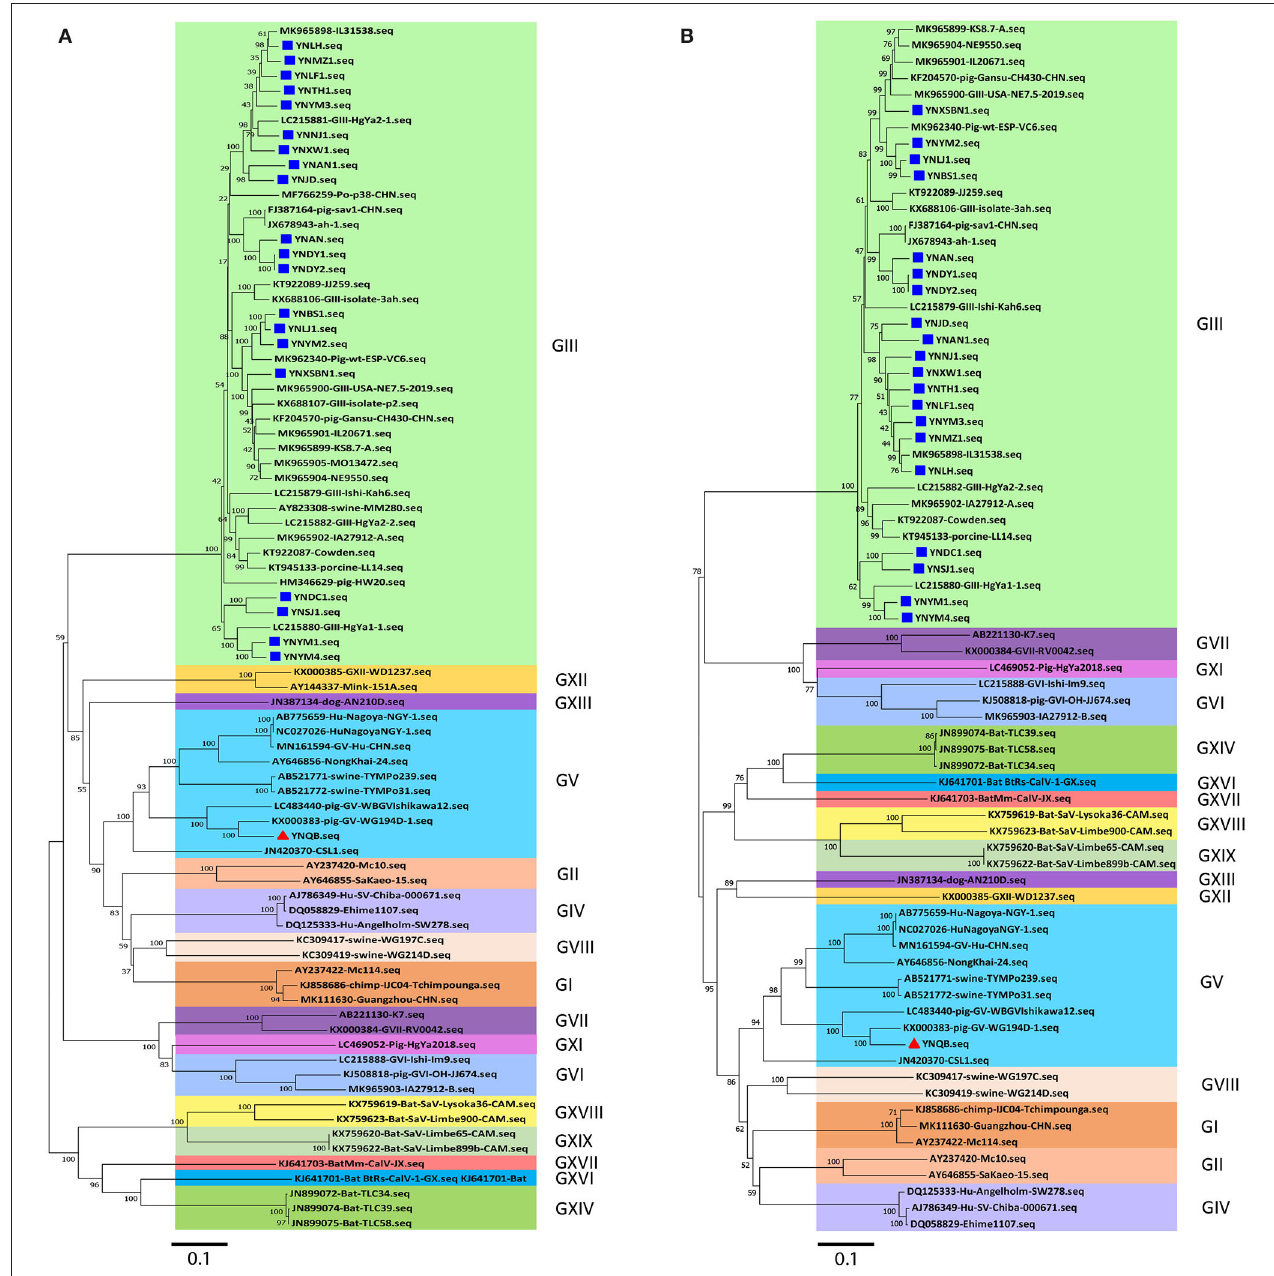
FIGURE 1 | Phylogenetic analysis of sapovirus sequences of VP1 (A) and capsid genes ( VP1 and VP2 ) (B) including the 20 Yunnan PoSaV-GIII strains (indicated with a solid blue square) and one Yunnan PoSaV-GV strain YNQB (indicated with a red triangle) determined in this study. The sequences retrieved from GenBank were labeled with their accession numbers ( Supplementary Table S3 ). The phylogenetic trees were constructed by neighbor-joining (NJ) method. Significant bootstrap values are indicated as a percentage for 1000 replicates. Bootstrap values higher than 50 are displayed along the relative branches. Different genogroups in blocks are color coded. The numbers in the trees indicate the confidence and the bars under the trees indicate the phylogenetic distance.